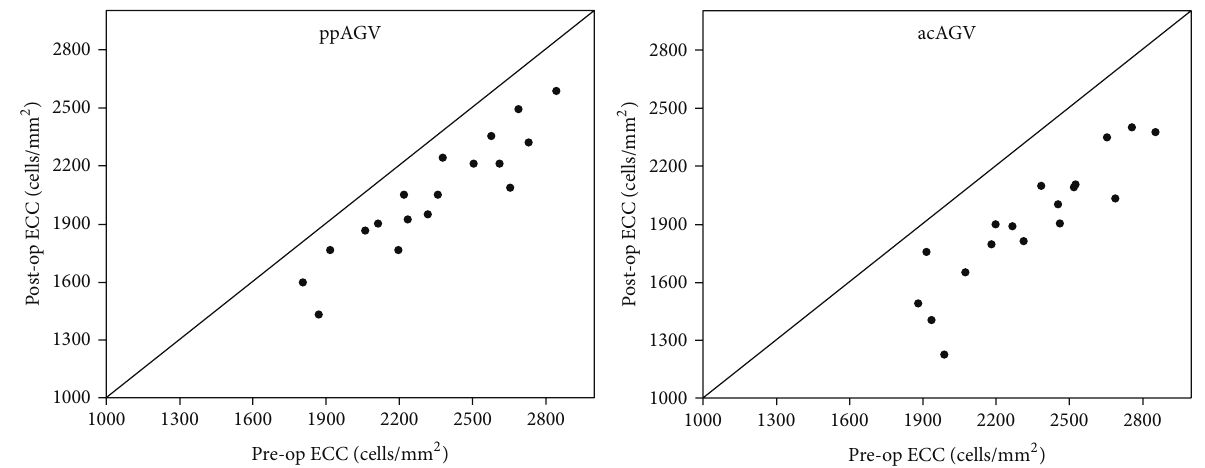
Figure 1: Scatter plots of change for each case in pars plana implantation and anterior chamber implantation of Ahmed glaucoma valve implant. ppAGV pars plana implantation of Ahmed glaucoma valve, acAGV anterior chamber implantation of Ahmed glaucoma valve, and ECC endothelial cell